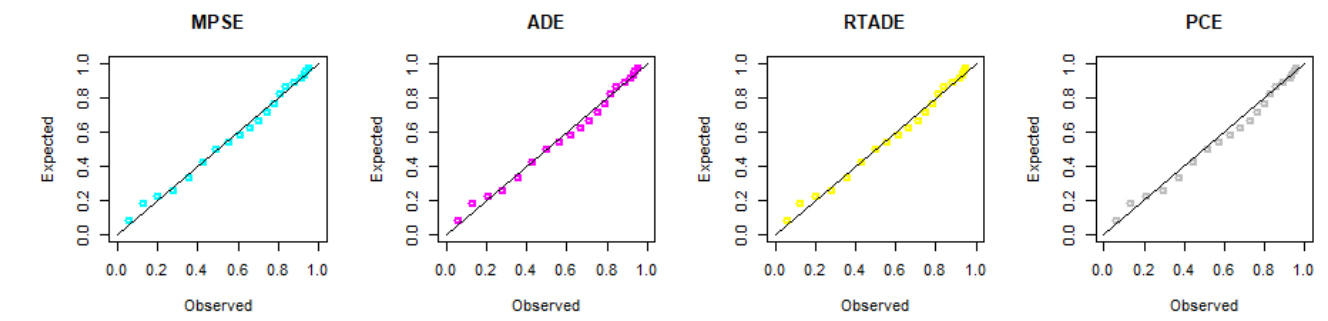
Figure 3. PP plots for COVID-19 data using the eight estimates.